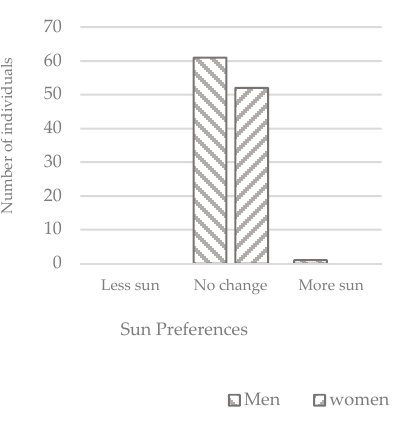
Figure 5. Percentages of preferences votes in winter.